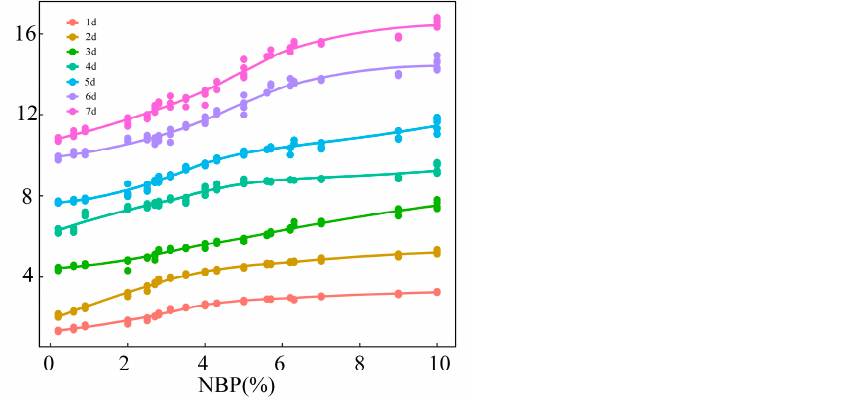
Figure 4. The relationship between nymph biomass proportion (NBP) and body mass of Asian short-toed lark ( Alaudala cheleensis ) nestlings ( n = 45). 1d, 2d, 3d, 4d, 5d, 6d, and 7d indicates the age of nestlings in days. NBP is the proportion of the daily grasshopper nymph biomass relative to the total biomass measured on all survey days.